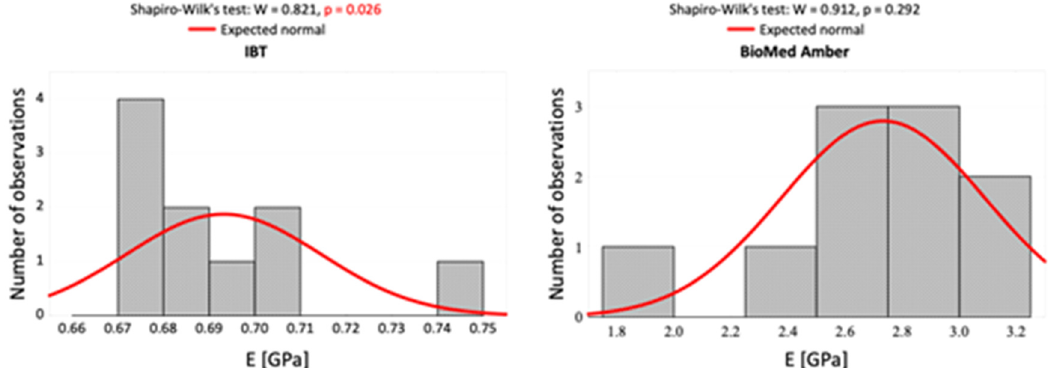
Figure 4. Histograms of the measurement results of Young’s modulus in the compression test against a background of normal data distribution for the two dental resins and the normality test results.